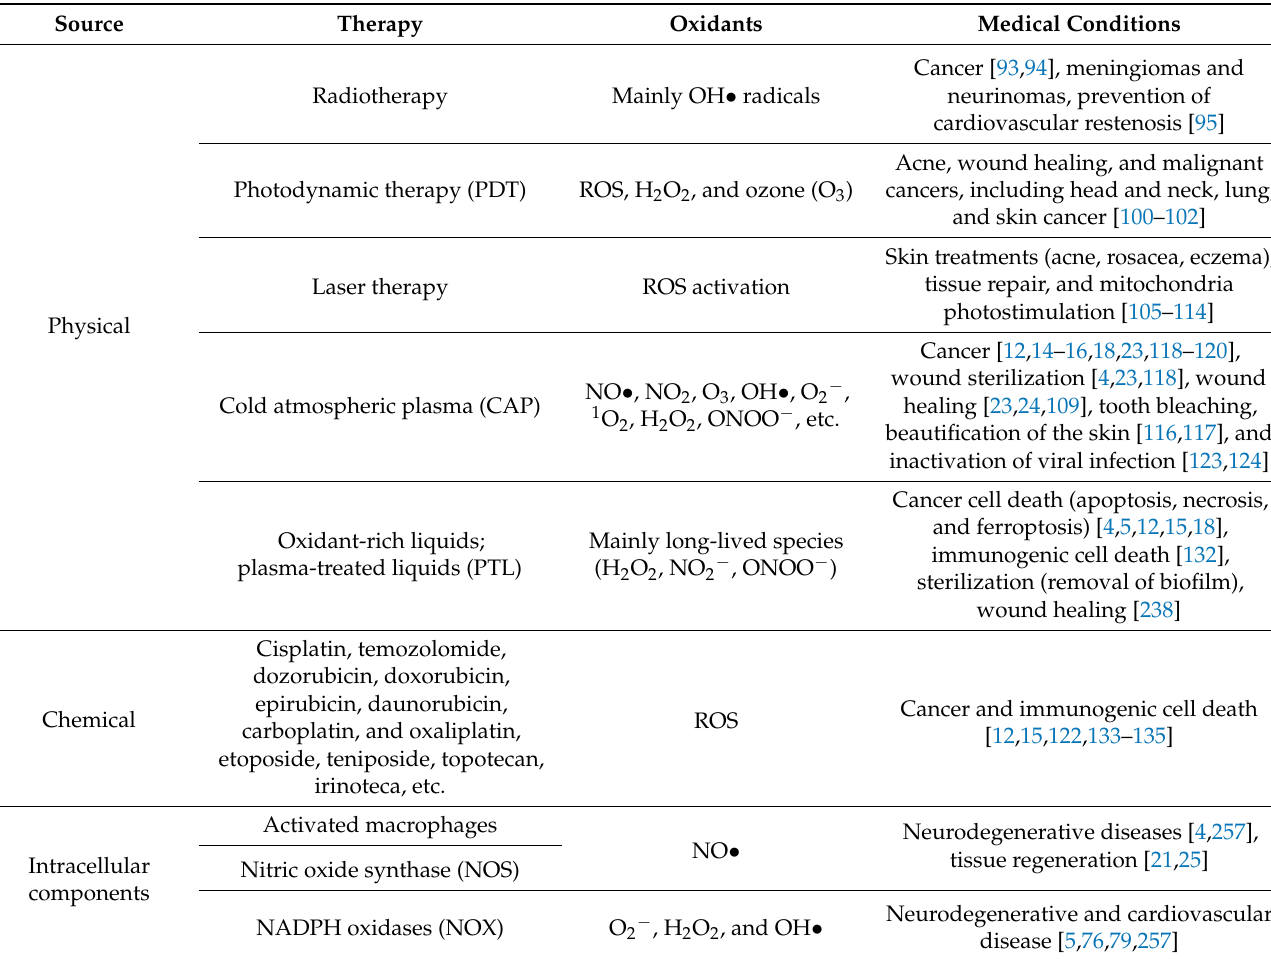
Table 3. Exogenous and endogenous sources of oxidants and their use in the treatment of various